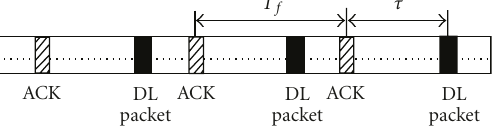
Table 1: Simulation Parameters of MIMO E-SDM